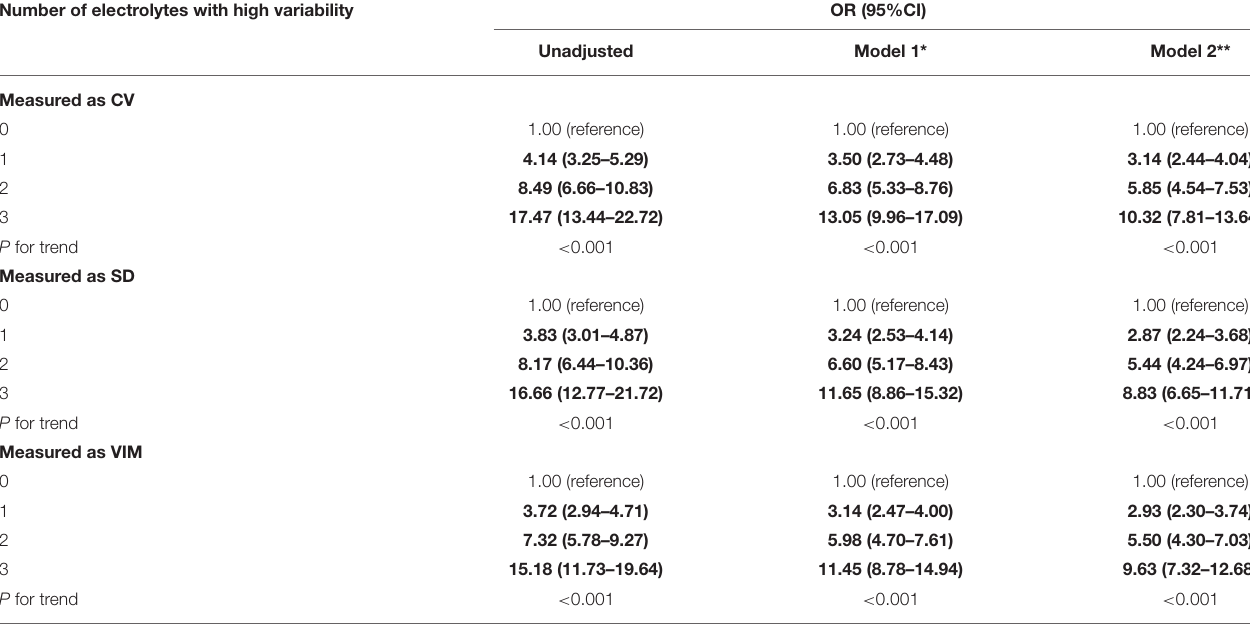
TABLE 3 | Odds ratios and 95% confidence intervals of in-hospital mortality by number of electrolytes with high variability. Number of electrolytes with high